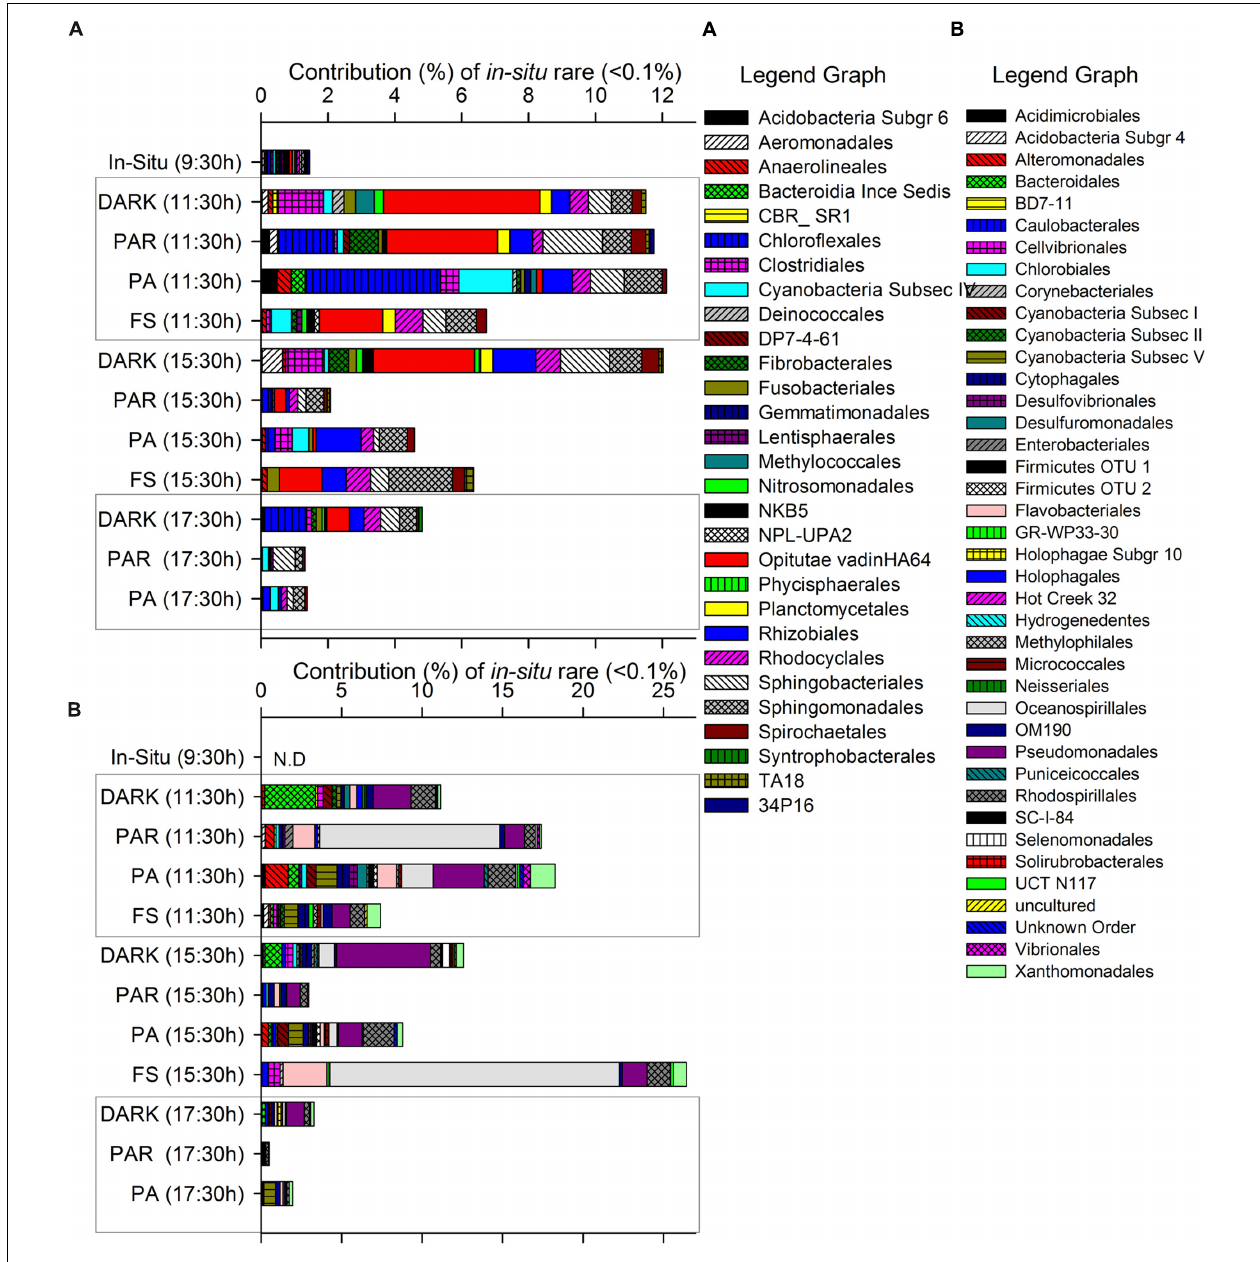
FIGURE 4 | Contribution of specific active taxa (mainly Orders when available) classified as rare according to their initial in situ pyrolibrary contribution as groups detected > 0- < 0.1% (A) or undetected 0% (B) and the changes determined during the incubation through the time of the experiment at the different